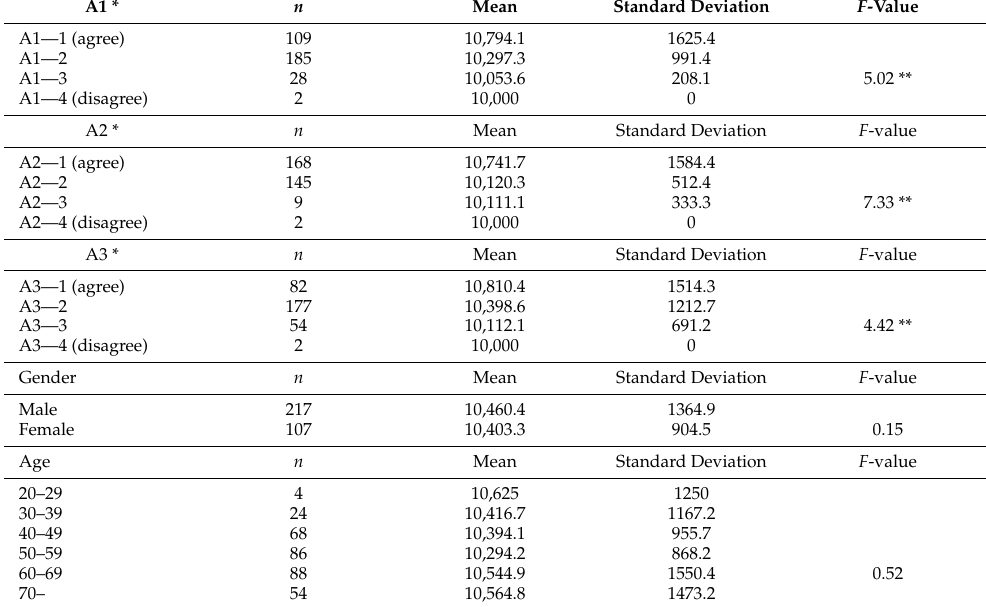
Table 7. Results of One-way ANOVA